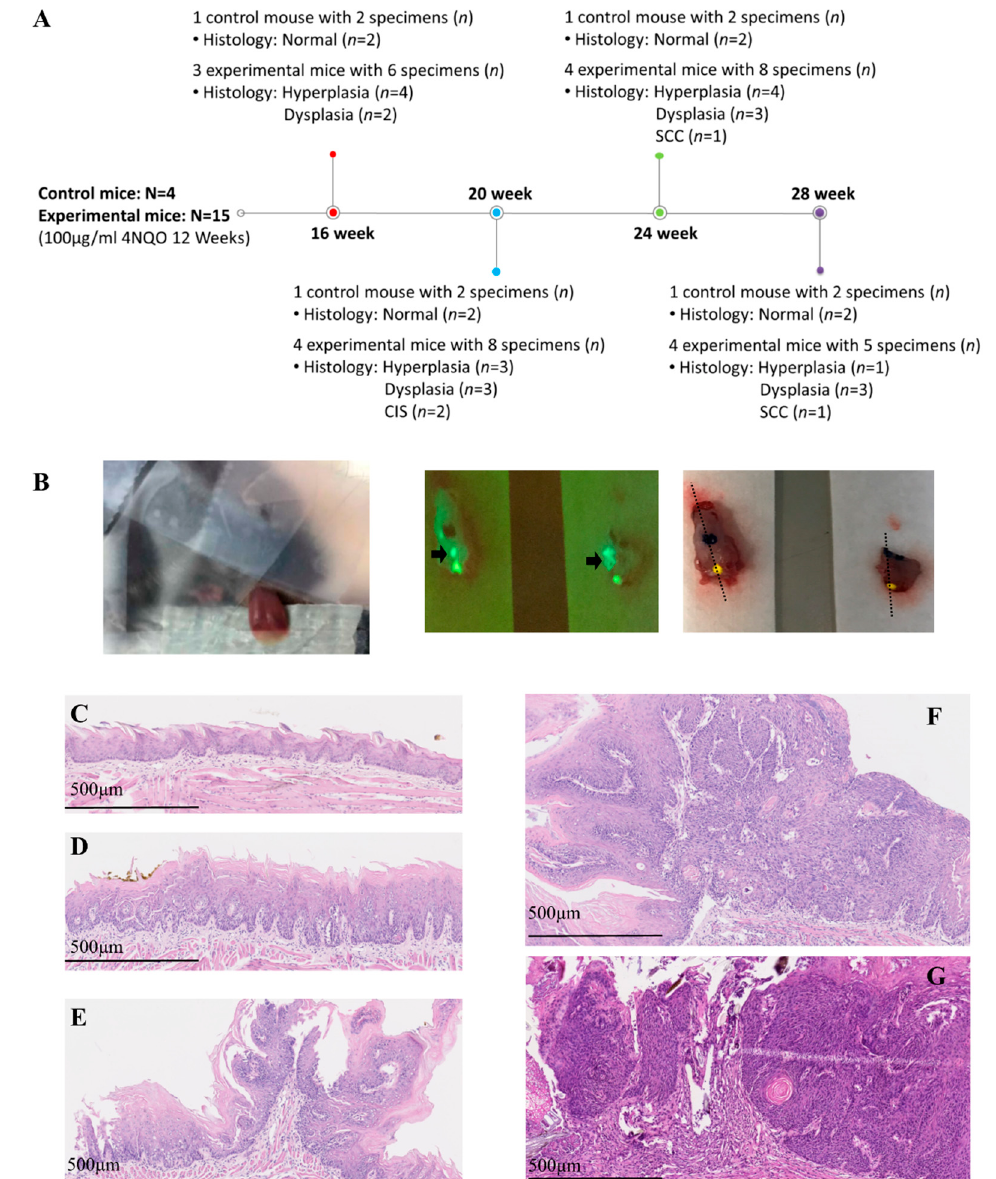
Figure 1. ( A ) Experimental schedule, number of mice ( N ), number of specimens ( n ), and histology results. ( B ) Polarization-sensitive optical coherence tomography (PS-OCT) scanning in vivo of the anterior tongue (left picture); fluorescence imaging to identify the green area, where indicates a potential tumor (middle picture, black arrow); and inking of the potential tumor area and histological sectioning on the black dotted line (right picture). ( C – G ) Histological definition of benign lesion: normal (C) and hyperplasia (D); histological definition of malignancy: dysplasia (E), carcinoma in situ (F), and squamous cell carcinoma (G).